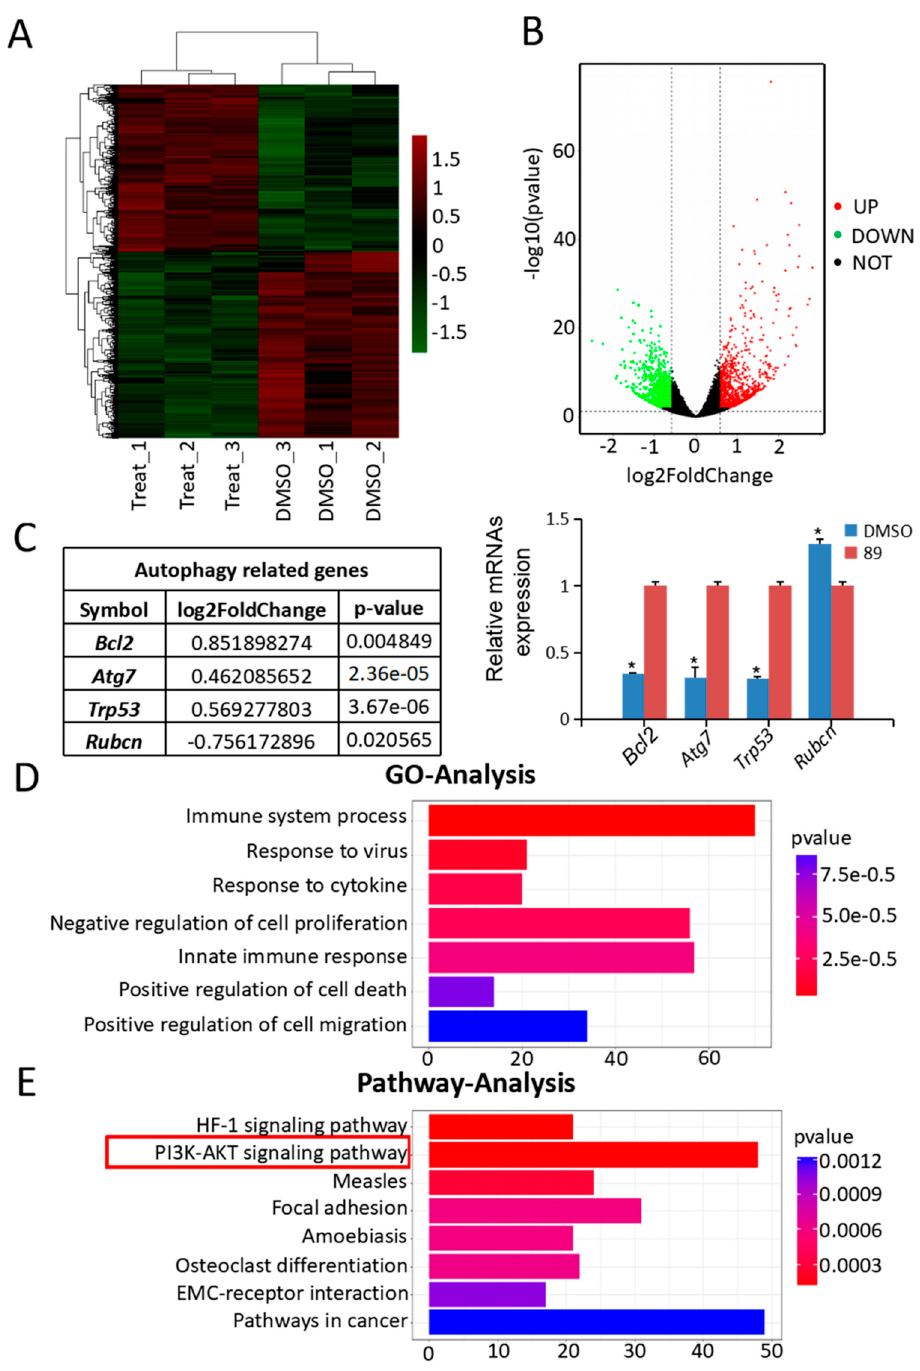
Figure 3. Analysis and validation of RNA-seq data. ( A ) Hierarchical clustering shows differentially expressed mRNA patterns between the control and C89-treated groups. ( B ) Volcano plot of differentially expressed mRNAs. A total of 1983 differentially expressed mRNAs were identified, including 937 upregulated and 1046 downregulated mRNAs. ( C ) Differentially expressed mRNAs were related to autophagy, and the qRT-PCR results were consistent with the changes in transcriptome profile ( p < 0.05). ( D ) Gene Ontology (GO) analysis of RNA-seq data. The top seven significantly enriched biological processes are shown. ( E ) Kyoto Encyclopedia of Genes and Genomes (KEGG) pathway analysis of RNA-seq data. The top eight enriched pathways are shown. * p < 0.05, ** p < 0.01, *** p < 0.001.